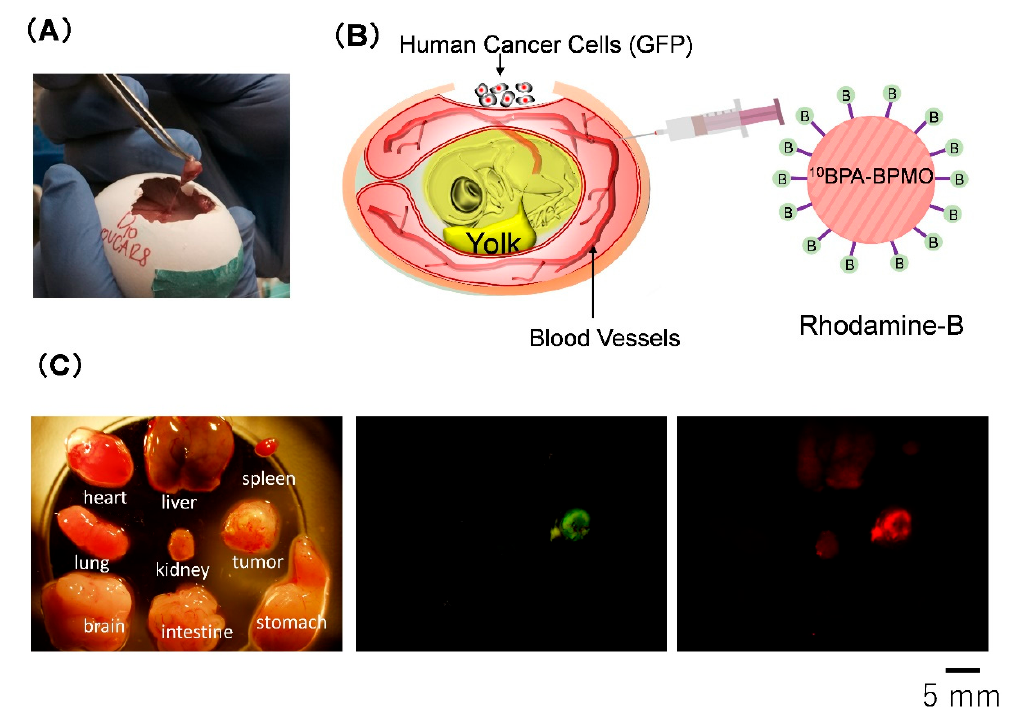
Figure 5. Characterization of nanoparticles by using the chorioallantoic membrane (CAM) assay. ( A ) Tumor formation on the CAM by transplanting cancer cells; ( B ) A CAM-based assay to examine tumor accumulation of nanoparticles. The tumor is formed using green fluorescence protein (GFP) expressing cells; ( C ) Detection of 10 BPA-BPMO in tumor and organs.